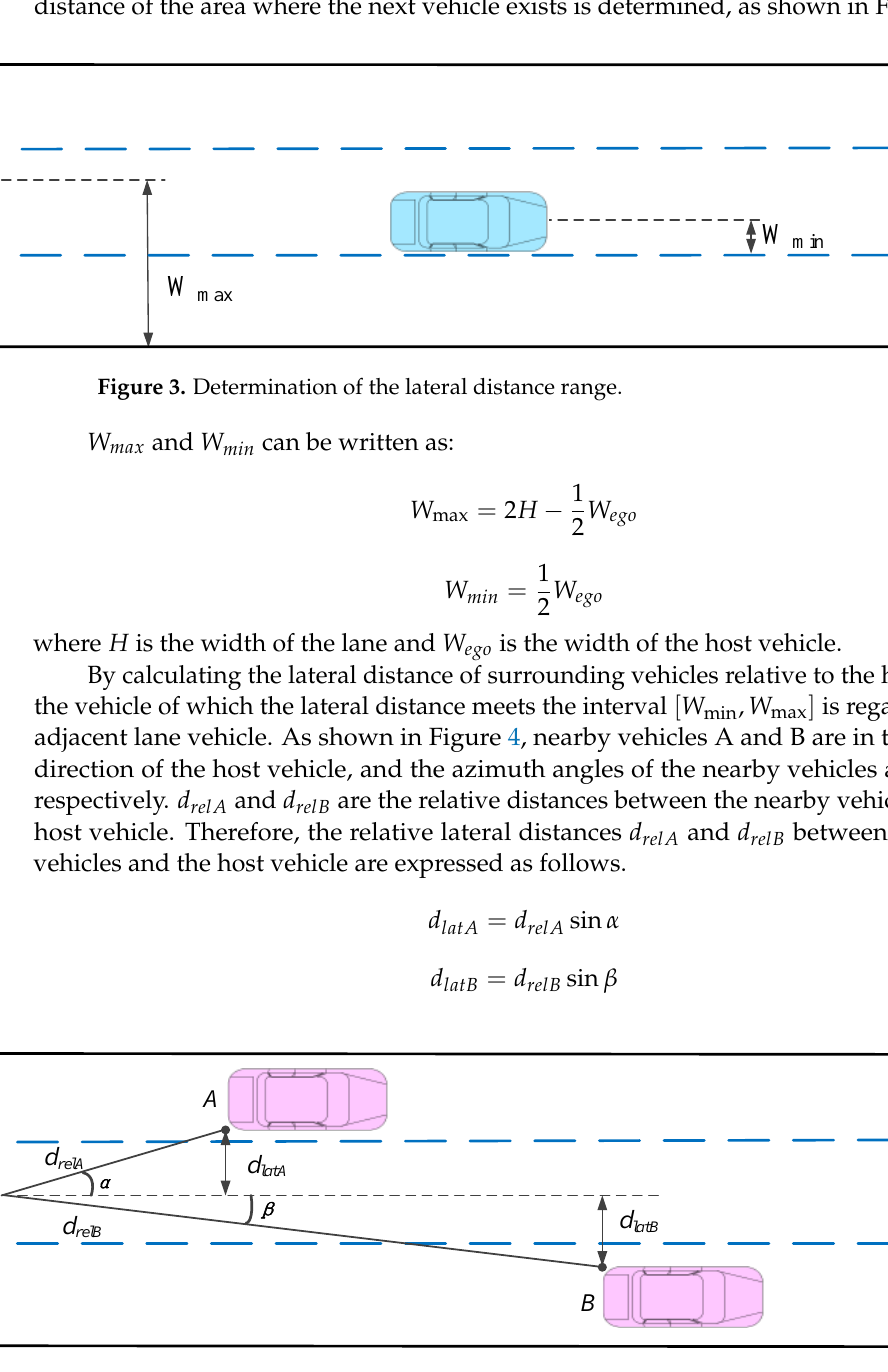
Figure 4. Calculation of the relative lateral distances of the nearby vehicles. When the lateral distances, d relA and d relB , of nearby vehicles A and B meet the interval [ W ] , the nearby vehicles are both regarded as adjacent lane min , W max